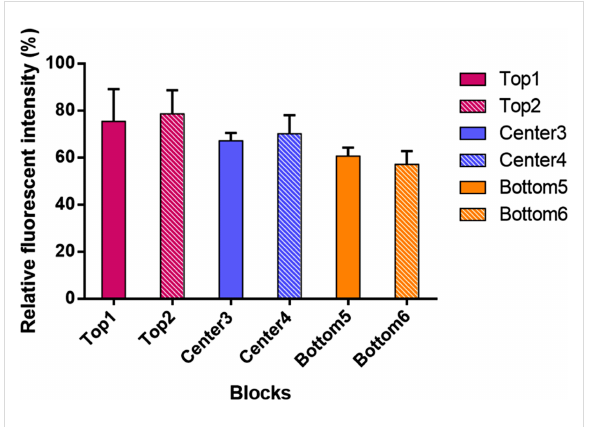
Figure 9: Quantitative fluorescent study on variance of the polymer coating across the microelectrode surface. Purple represents blocks from the top region. Blue represents blocks from the center region. Orange represents blocks from the bottom